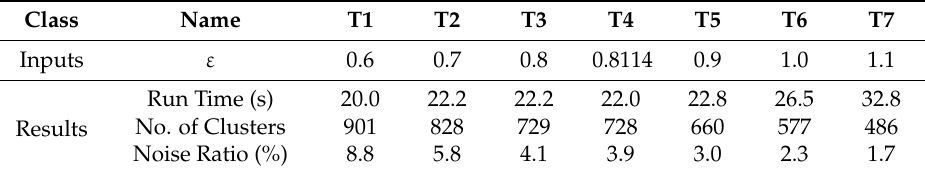
Table 1. The segmentation results using different ε for airborne laser scanning data using X , Y , Z fields.